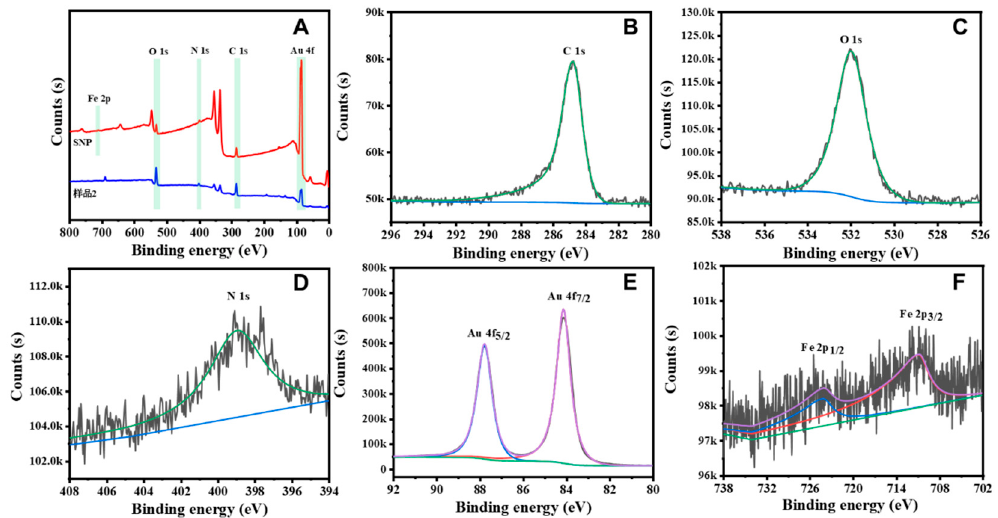
Figure 2. XPS pattern of Au@SNF NPs ( A ), High resolution XPS spectra of ( B ) C 1s, ( C ) O 1s, ( D ) N 1s, ( E ) Au 4f, ( F ) Fe 2p.